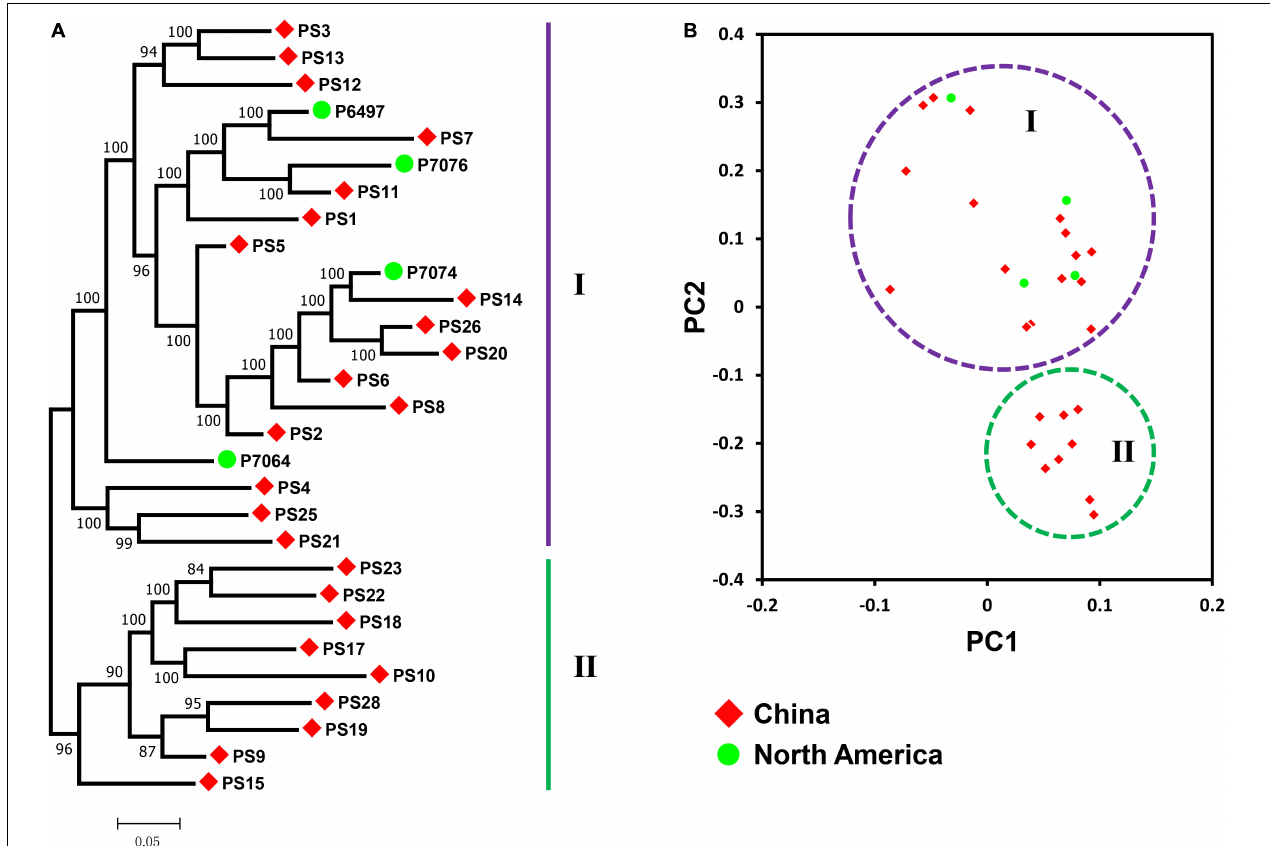
FIGURE 2 | Population structure in P. sojae . (A) Phylogenetic analysis of P. sojae populations with all detected SNPs. The maximum likelihood tree was constructed using PhyML v3.0 with 1000 bootstrap replicates. Groups I and II are designated using the purple and green lines, respectively. (B) Principal component (PC) analysis of P. sojae populations with all detected SNPs. Principal component analysis was performed by SNPRelate. Groups I and II are encircled using the purple and green circles, respectively. Red diamonds represent isolates collected from China. Green circles represent isolates collected from North